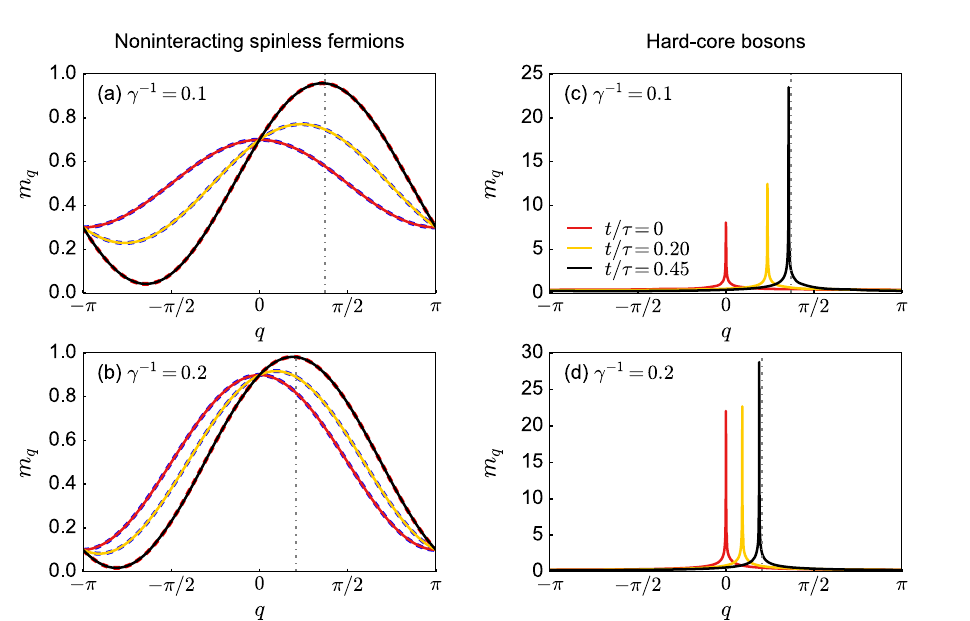
FIG. 3. Dynamics of the quasimomentum distribution function m q ð t Þ . (a),(b) m q ð t Þ for N ¼ 1000 noninteracting spinless fermions. (c),(d) m q ð t Þ for N ¼ 1000 hard-core bosons. Results are shown for γ − 1 ¼ 0 . 10 in (a) and (c) and for γ − 1 ¼ 0 . 20 in (b) and (d). Solid lines depict the numerical results, while the dashed lines in (a) and (b) are obtained using Eq. (31). Dotted vertical lines in all panels represent the shift of the peak in m q ð t Þ at time t= τ ¼ 0 . 5 , and is given by Eq.